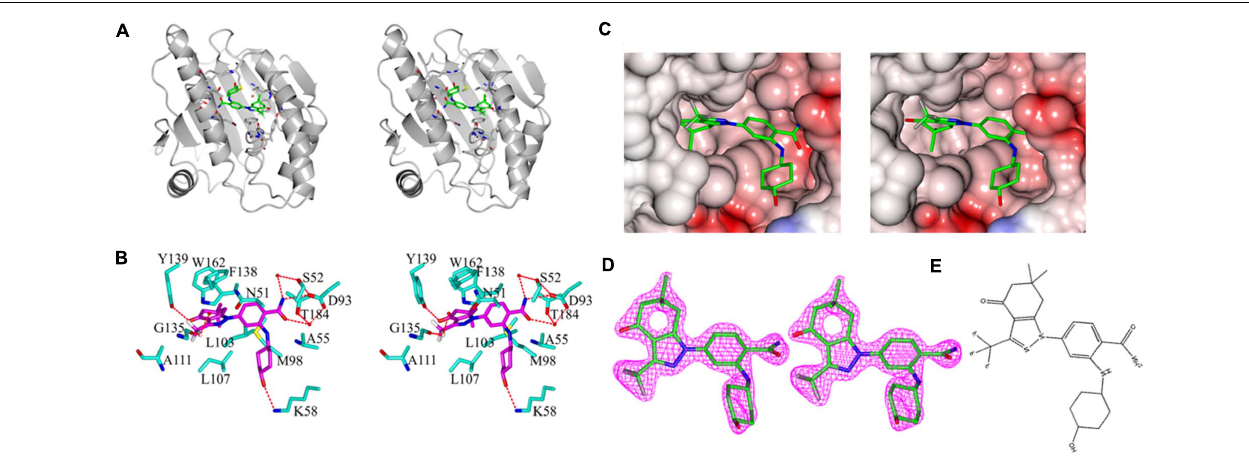
FIGURE 5 | Stereo images of complex crystal structure of Hsp90 N -SNX-2112. (A) Overall structure of Hsp90 N -SNX-2112. Hsp90 N and SNX-2112 are shown as cartoon and stick, respectively. (B) Molecular interaction between SNX-2112 and Hsp90 N . The carbon, nitrogen, oxygen, and fluorine atoms of SNX-2112 are colored in magenta, blue, red, and white, respectively. In addition, the carbon, nitrogen, oxygen, and sulfur atoms of Hsp90 N residues are shown in cyan, blue, red, and yellow, respectively. The hydrogen bonds are represented as red dashed lines. The red balls are on behalf of water molecules. (C) Electrostatic potential surface distribution of complex crystal structure of Hsp90 N -SNX-2112. The crystal structure surface is colored to reflect the electrostatic potential: red for negative charge and blue for positive charge. The carbon, nitrogen, oxygen, and fluorine atoms of SNX-2112 are colored in green, blue, red, and gray, respectively. (D) Electron density map (2 Fo - Fc ) of SNX-2112. SNX-2112 is shown as stick. (E) Chemical structure of